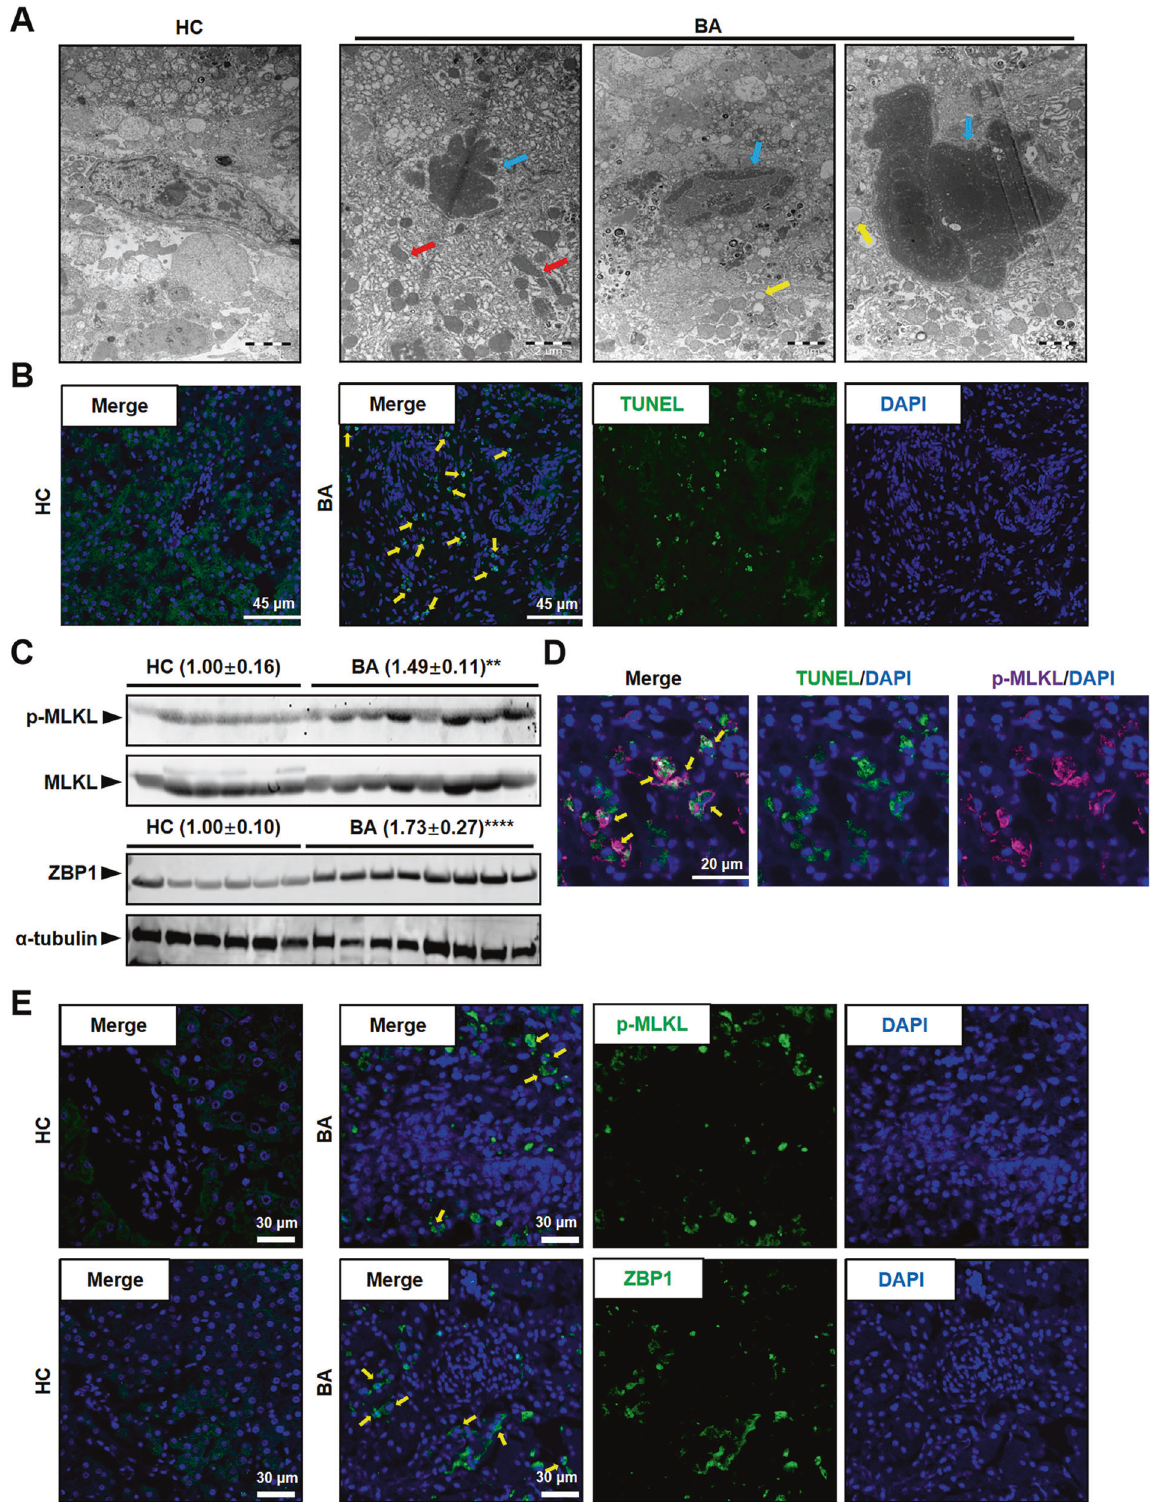
Fig. 1 Necroptosis existed in BA livers. A Representative TEM images in normal adjacent non-tumor livers (HC) and biliary atresia (BA) livers. Red arrows indicate enlarged mitochondria, blue arrows indicate swollen nucleus, and yellow arrows indicate enlarged vacuoles. Scale bar: 2 μ m. B Representative TUNEL staining images in HC and BA livers. Yellow arrows: TUNEL + cells. Scale bar: 45 μ m. C Western blot analysis for p-MLKL and ZBP1 in the liver tissues from BA ( n = 8) and HC ( n = 6). Blots of p-MLKL were normalized to MLKL, and blots of ZBP1 were normalized to α -tubulin. D Representative image of TUNEL (green) and p-MLKL (pink) staining in BA livers. Yellow arrows: TUNEL + p-MLKL + cells. Scale bar: 20 μ m. E Representative images of p-MLKL (green) or ZBP1 (green) staining. The nuclei were stained with DAPI (blue). Yellow arrows: p-MLKL + or ZBP1 + cells. Scale bar: 30 μ m. Data are presented as the mean ± SEM. ** p < 0.01, **** p < 0.0001 (versus control).